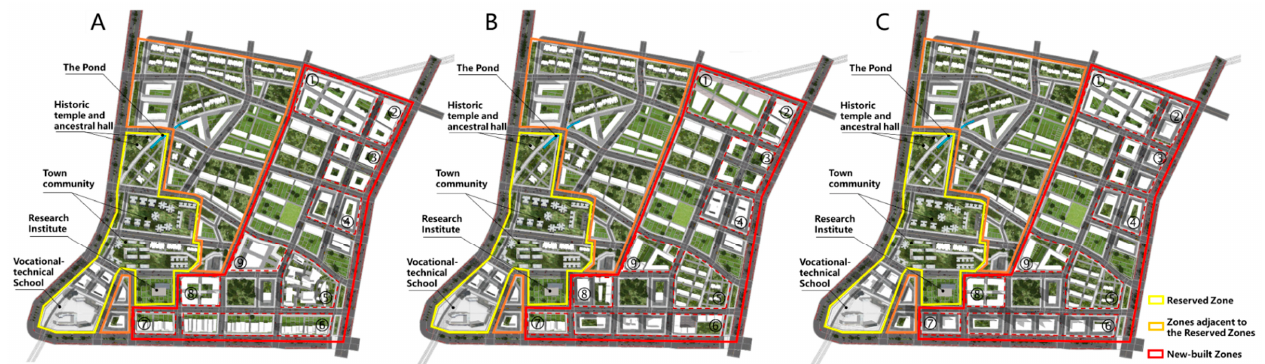
Figure 11. Three alternative proposals in the H-Village project (( A – C ) sharing the same reserved zones and the zones adjacent to the reserved zones but differing in the newly built zones, mainly consisting of business parcels and residential parcels, especially Blocks 1–9).